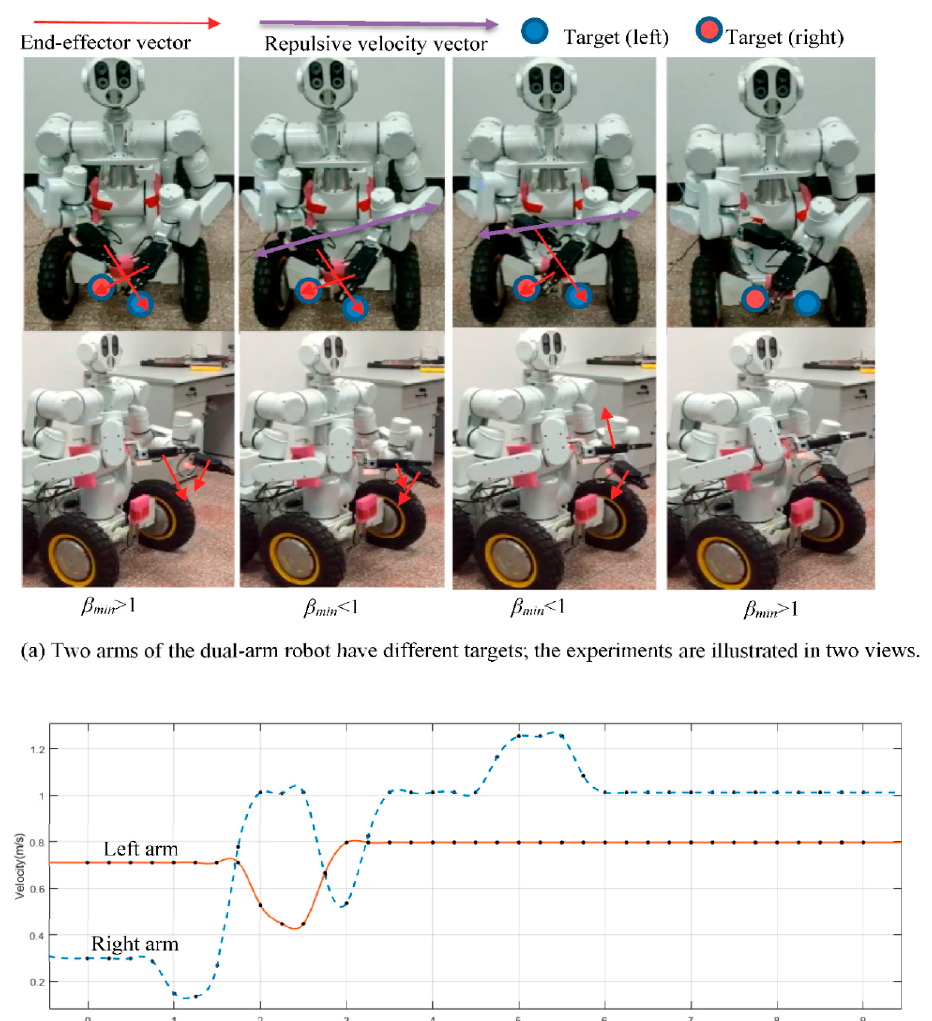
Figure 11. Experiment to assess the ability of a dual-arm system to avoid self-collision when the left and right arms have the same target. ( a ) The first experiment ; ( b ) Velocity profile of the end-effector of each arm; ( c ) Trajectory of the end-effector of each arm.